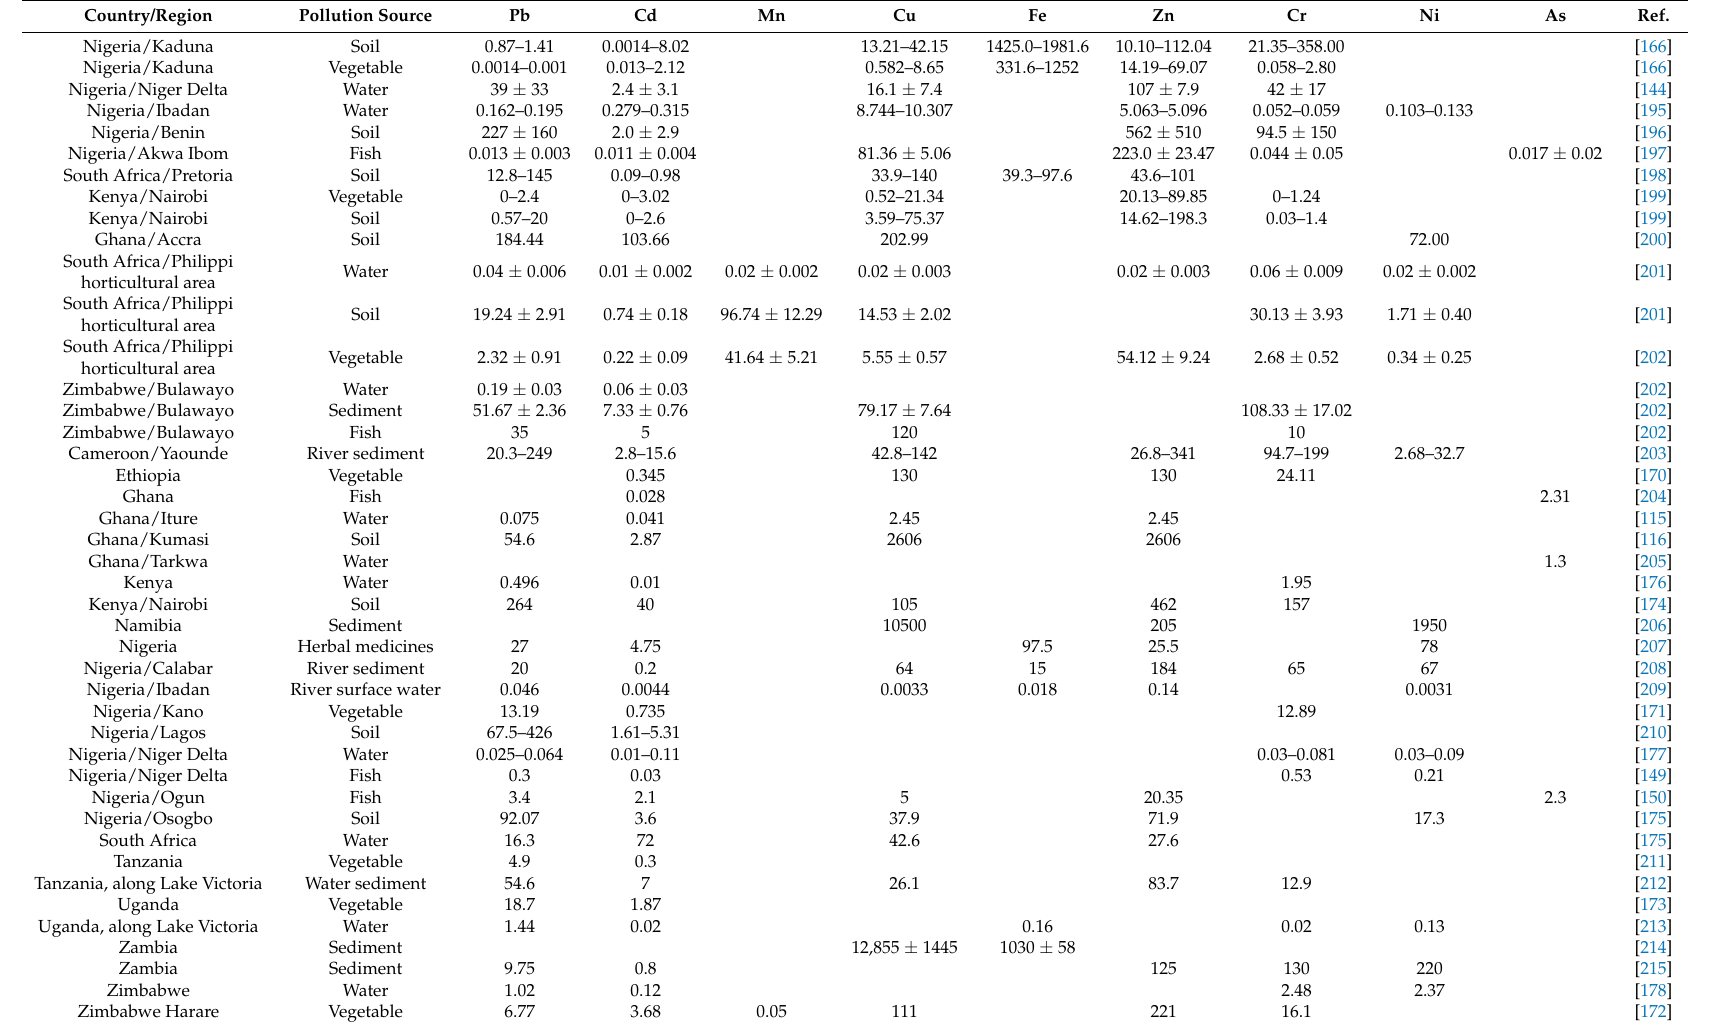
Table 1. Heavy metal pollution in Sub-Saharan